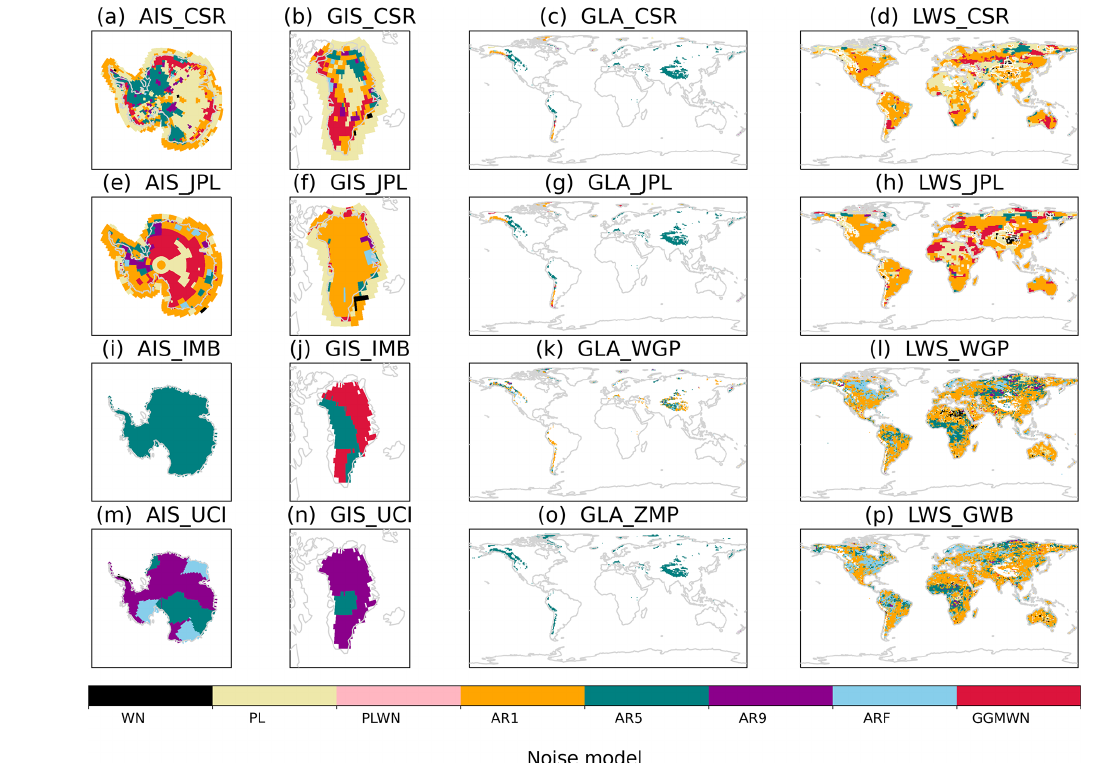
Figure 3. Noise model selection based on the time series of the different sources of mass loss for each dataset (rows) and contribution (columns), over the period